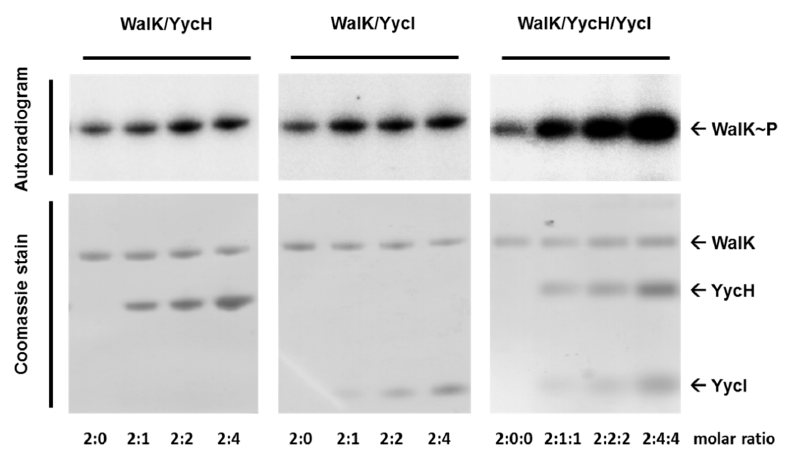
Figure 3. Activation of WalK autophosphorylation by YycH and YycI in phospholipid liposomes. WalK was reconstituted separately and with increasing amounts of YycH and / or YycI into phospholipid liposomes with molar ratios of 2:1, 2:2, and 2:4 for WalK(monomer) / YycH and WalK / YycI and 2:1:1, 2:2:2, and 2:4:4 for WalK / YycH / YycI. Autophosphorylation was started using [ γ 32 P]-ATP and liposomes were loaded on a 10% SDS-PAGE gel. WalK with bound radiolabeled phosphate was visualized using a storage phosphor screen (top) and the gels were stained with Coomassie afterwards (bottom). Representative autoradiograms and Coomassie stained gels of three di ff erent experiments are shown. were present in the liposomes.